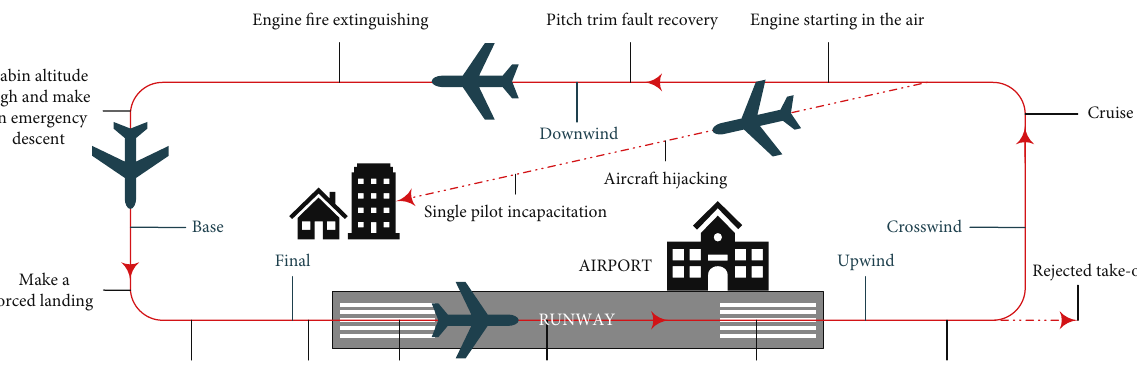
Figure 5: Flight diagram of commercial aircraft tra ffi c